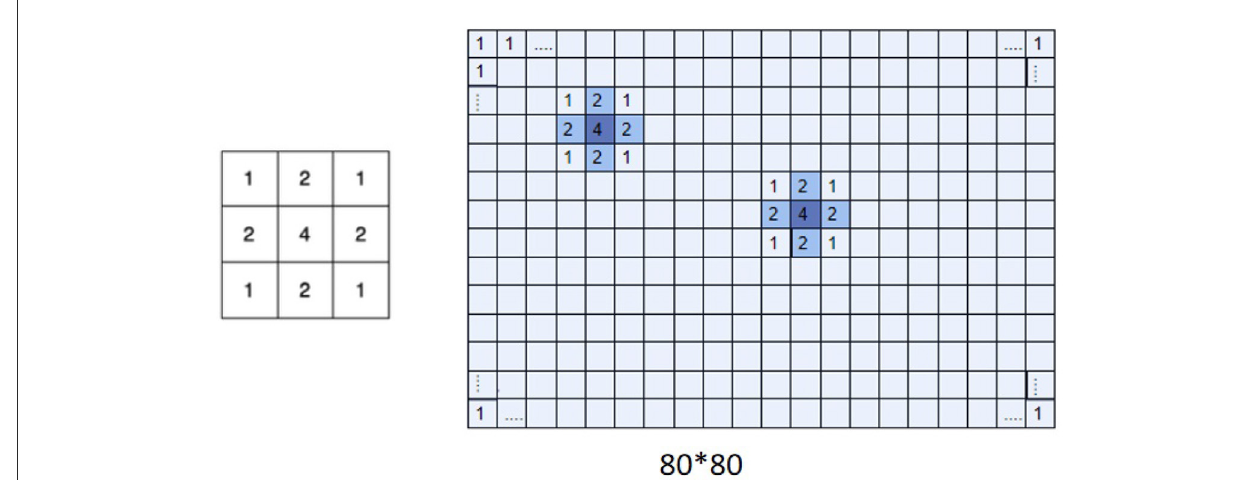
FIGURE5 Gaussian kernel and receptive field weight matrix. Multiplication of W matrix (right) with Gaussian kernel (left) . The W matrix represents the importance of the different regions of an image. The figure displays a weight matrix of size 80 × 80.